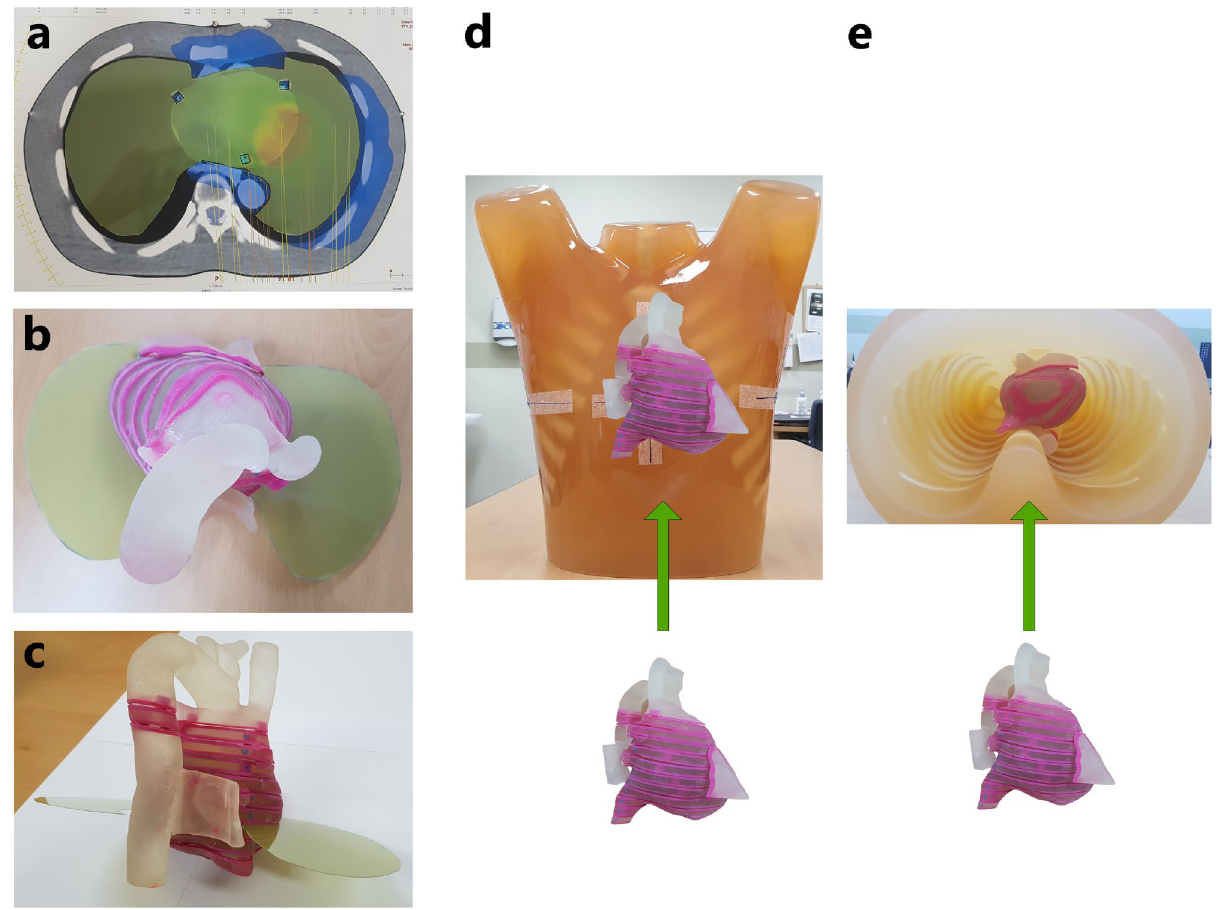
Figure 2. Film dosimetry set-up with 3D printed cardiac phantoms. ( a ) Axial view, ( b ) top-down view, ( c ) lateral view of the 3-D cardiac phantom, and ( d ) anterior-oblique view, ( e ) bottom-up view of the Lungman phantom inserted 3-D printed cardiac phantom.